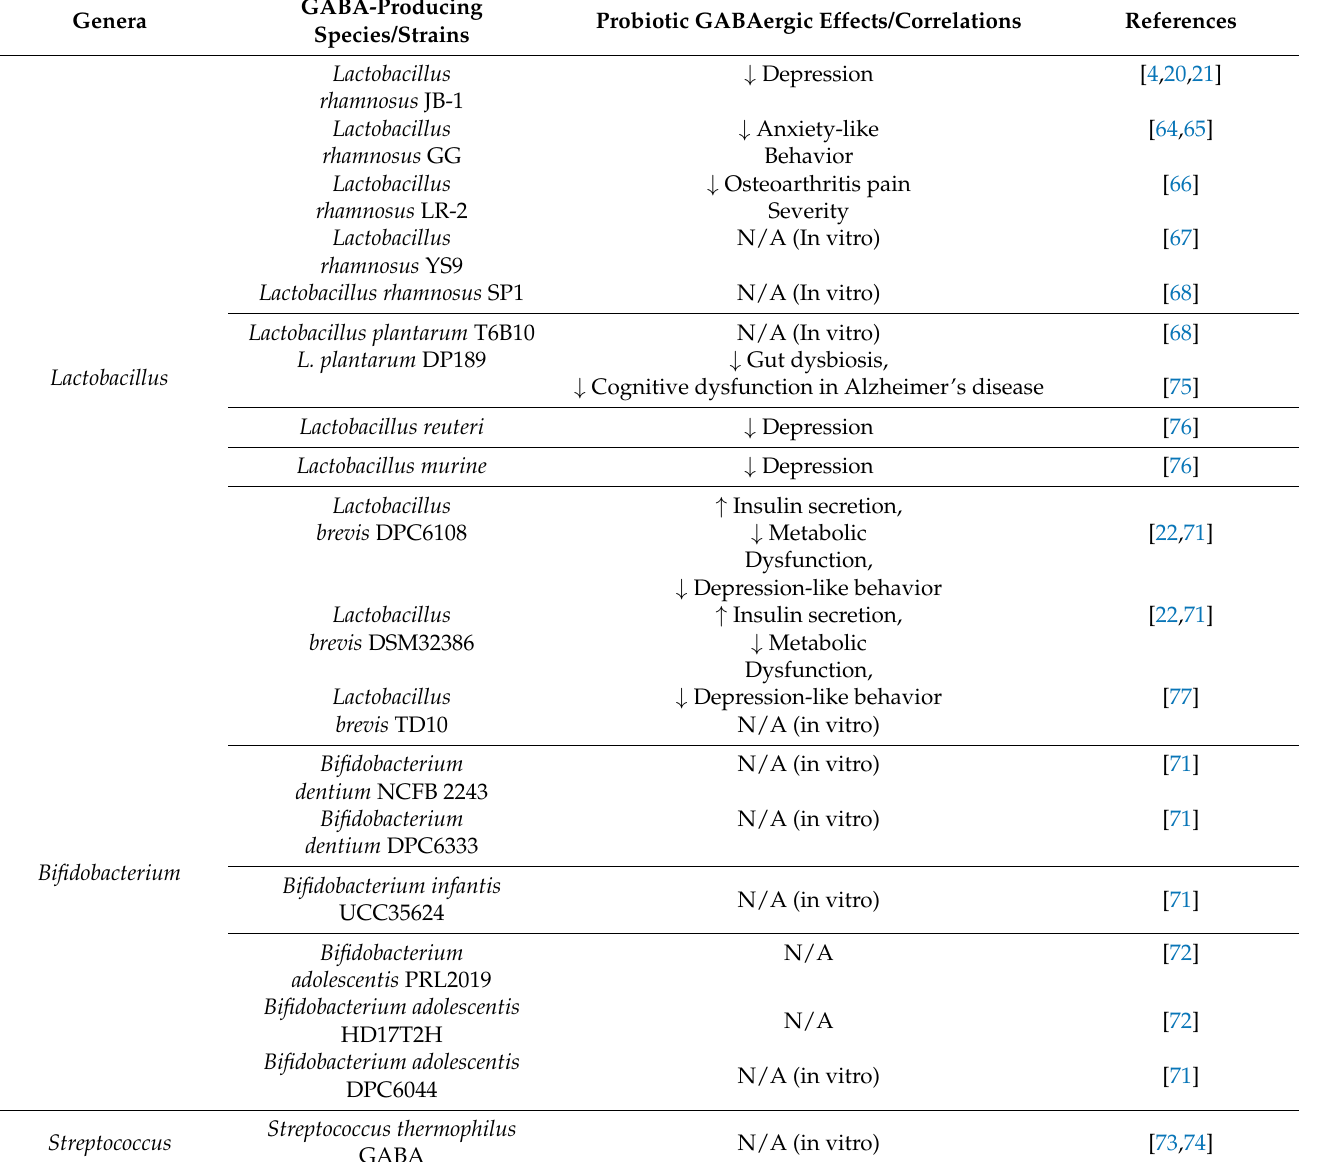
Table 2. Common GABA-producing bacterial species, strains, and their